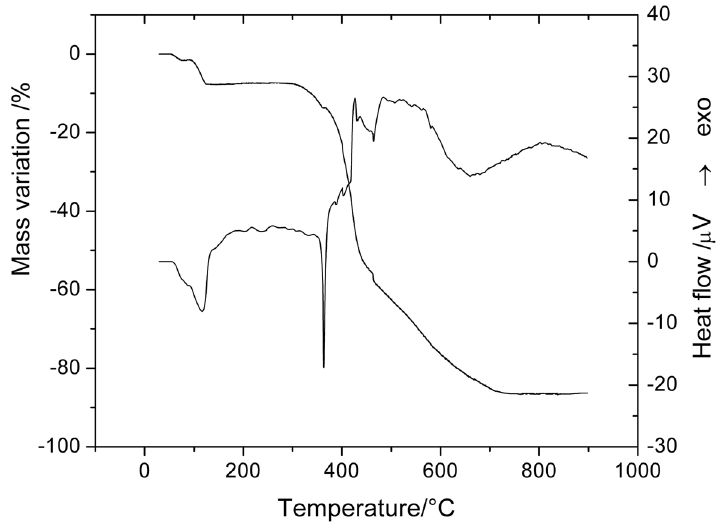
(H O) ] ⋅ 0.5H 2 2 2 2